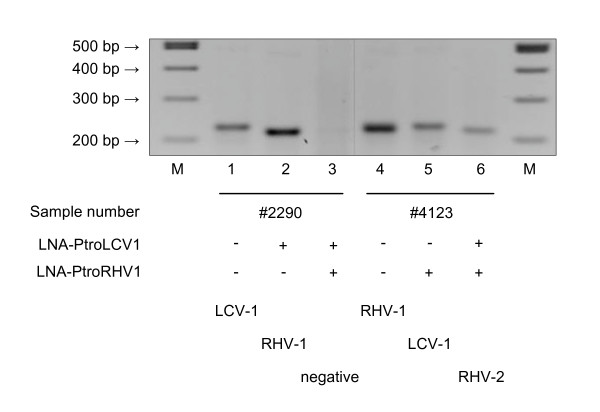
Pan-herpes DPOL PCR of chimpanzee samples in the presence or absence of LNA. Pan-herpes DPOL PCR was carried out on aliquots of chimpanzee Leo's spleen (#2290; #4123) in the absence (-) or presence (+) of LNA-PtroLCV1 and/or LNA-PtroRHV1. The electropherogram is shown. Below, the amplified DPOL sequences are indicated. Marker: 100 bpladder (lanes 1 and 8).